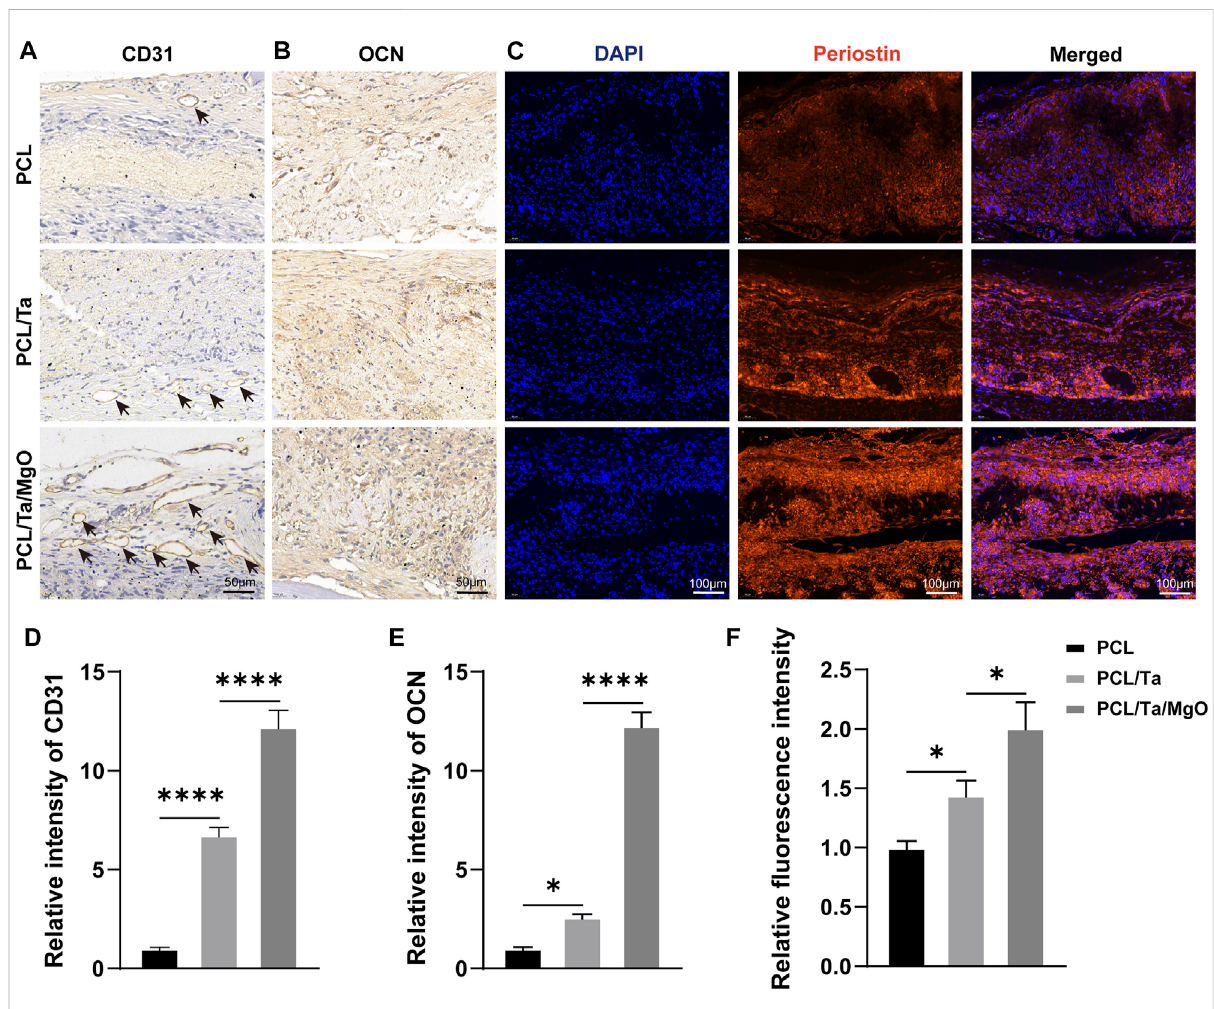
FIGURE 8 Representative images of immunohistochemical staining for (A) CD31 and (B) OCN. Black arrows: vessels around the membranes. (C) Immuno fl uorescence staining of periostin in the defect areas at 4 weeks. Quantitative assessment of the staining intensities of (D) CD31, (E) OCN, and (F) periostin ( n = 3). (* p < 0.05, ** p < 0.01, *** p < 0.001, and **** p <